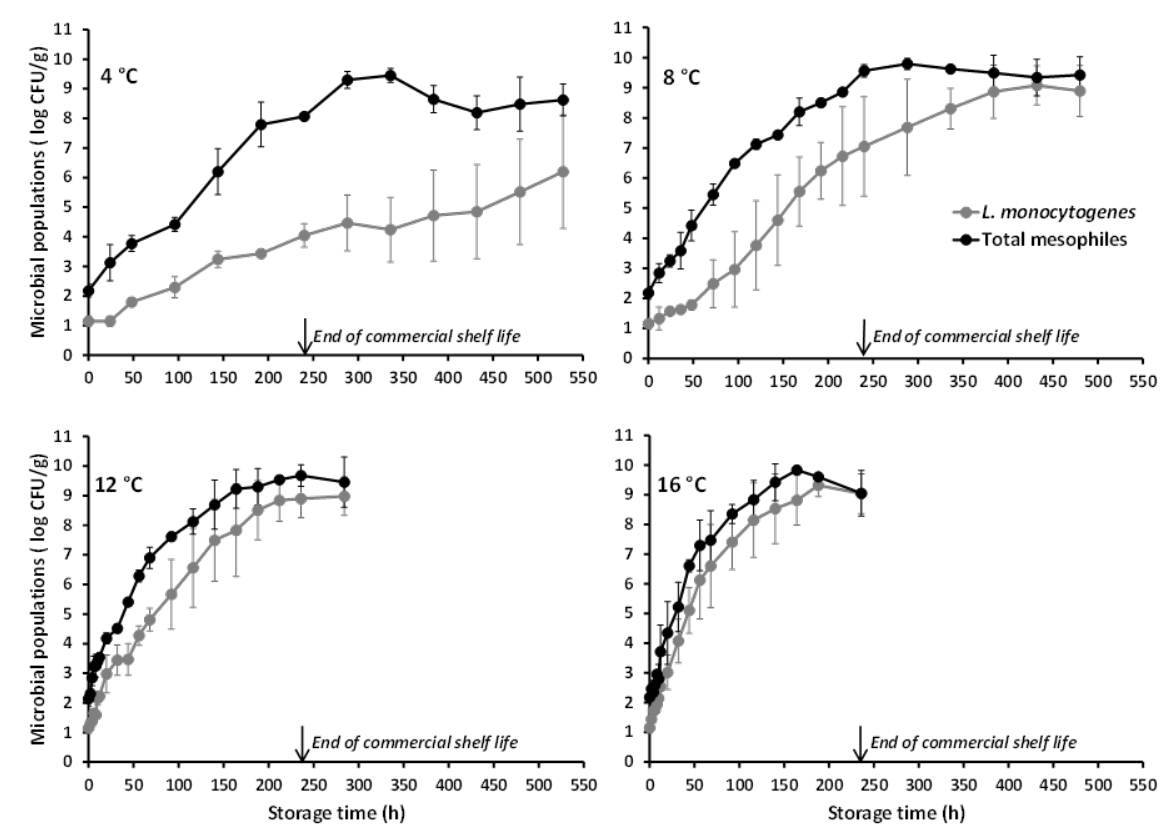
Figure 1. Mean ( ± standard deviation, n = 4) populations of Listeria monocytogenes and total mesophiles in battered chicken nuggets, artificially inoculated with the pathogen and stored at different temperatures.